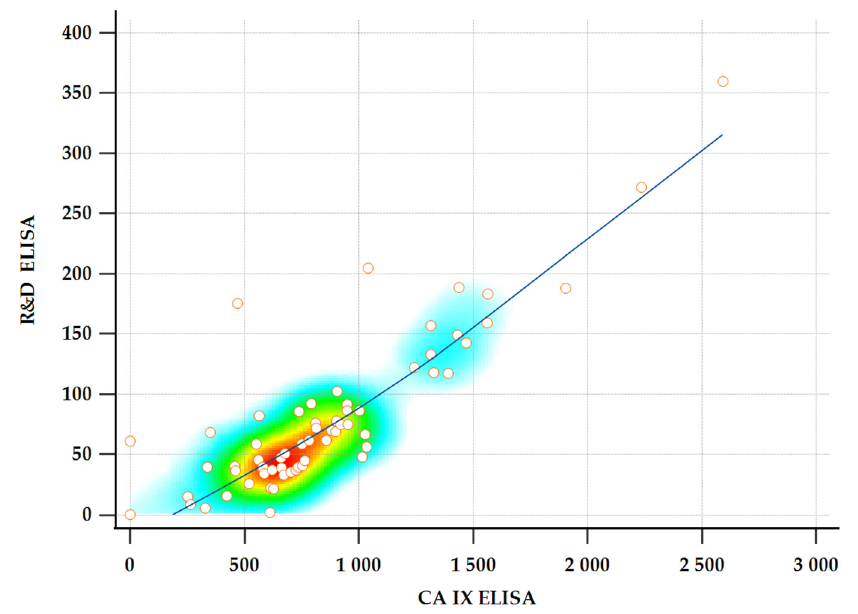
Figure A9. Scatter diagram of the degree of correlation between sCA IX concentrations measured by R&D ELISA versus CA IX ELISA.